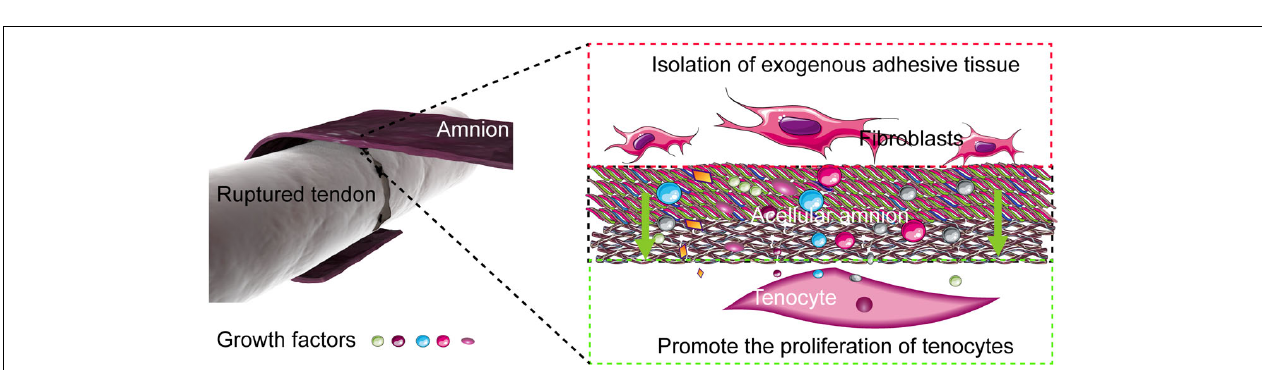
FIGURE 6 | Exemplary images of inflammatory cell and fibroblast infiltration visualized by immunohistological CD68 (monocytes/macrophages) (A–C) and vimentin (fibroblasts/tenocytes) (E–G) staining in ruptured tendons between the control group and amnion group at the 2nd week after operation. The CD68 and vimentin of the acellular amniotic membrane group were higher than that of the control group (D,H) . High expression of CD68 and vimentin in the amnion group meaned that a large number of monocytes/macrophages infiltrated, neovascularization increased, and fibroblasts/tenocytes proliferated rapidly. * p < 0.05.